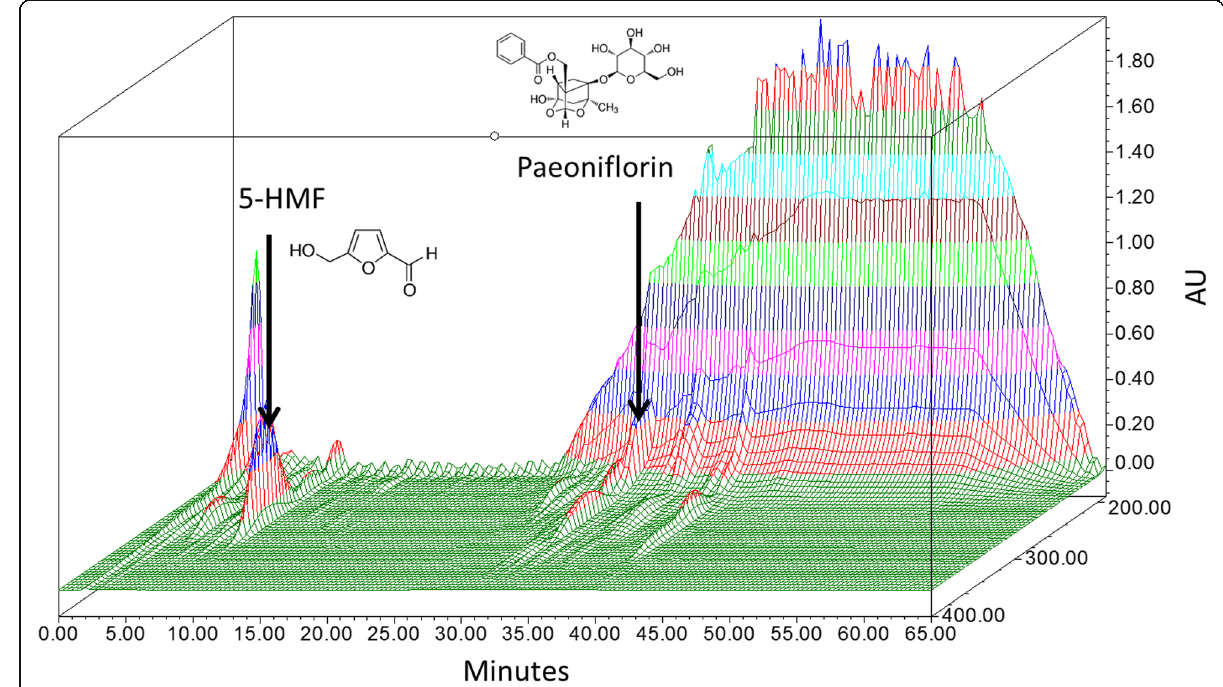
Fig. 1 Three-dimensional high-performance chromatography of Yukmijihwangtang